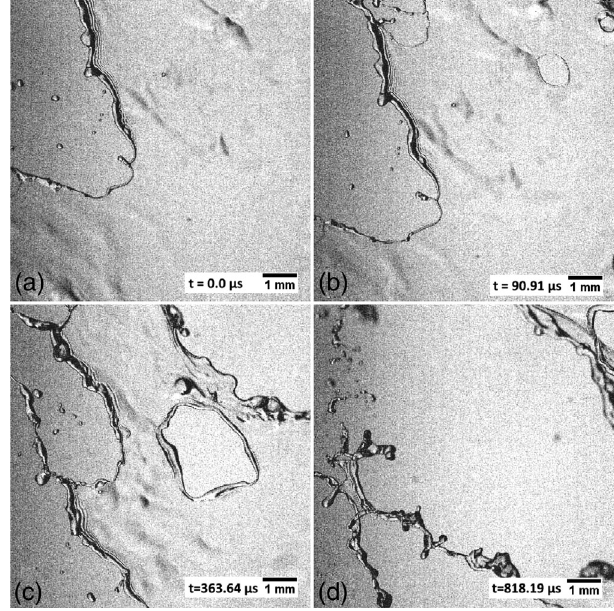
FIG. 7. The formation of ligaments for a flat fan nozzle. At first, there appears a wrinkle on the surface of the sheet (a), followed by the creation of a hole (b), with the subsequent expansion of the hole (c) and formation of ligaments